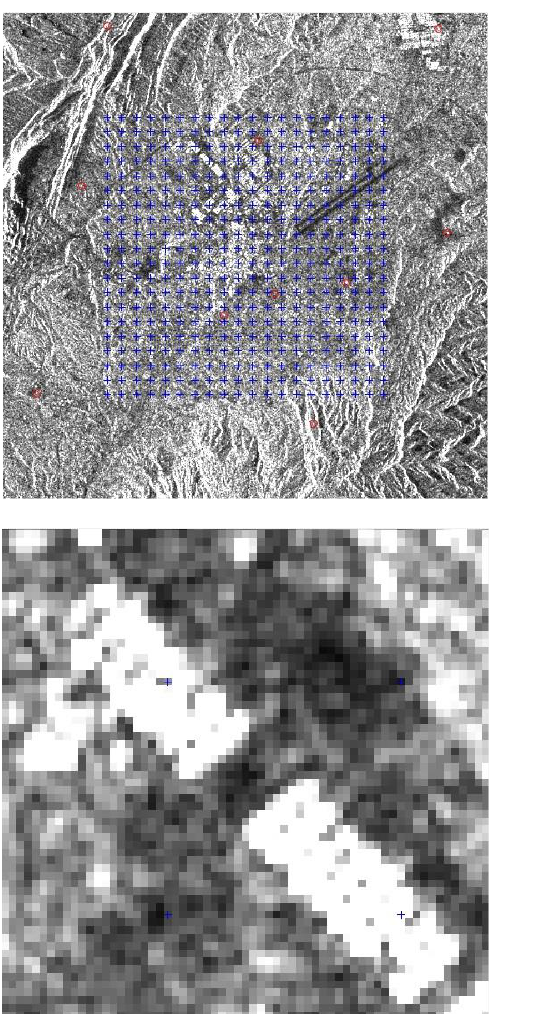
Figure 5. grid of points on master image(up and left), matched points on slave image(up and right). and sample of some matched